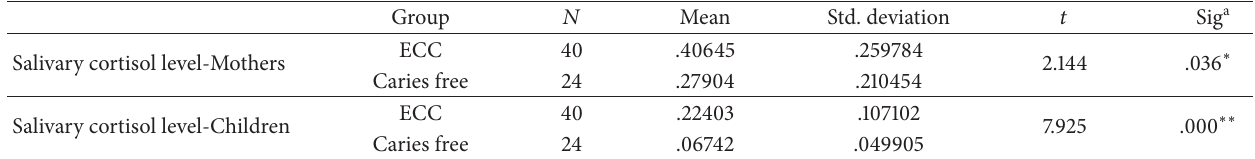
Table 2: Comparison of mean salivary cortisol levels in children and mothers of children with and without early childhood caries. Group 𝑁